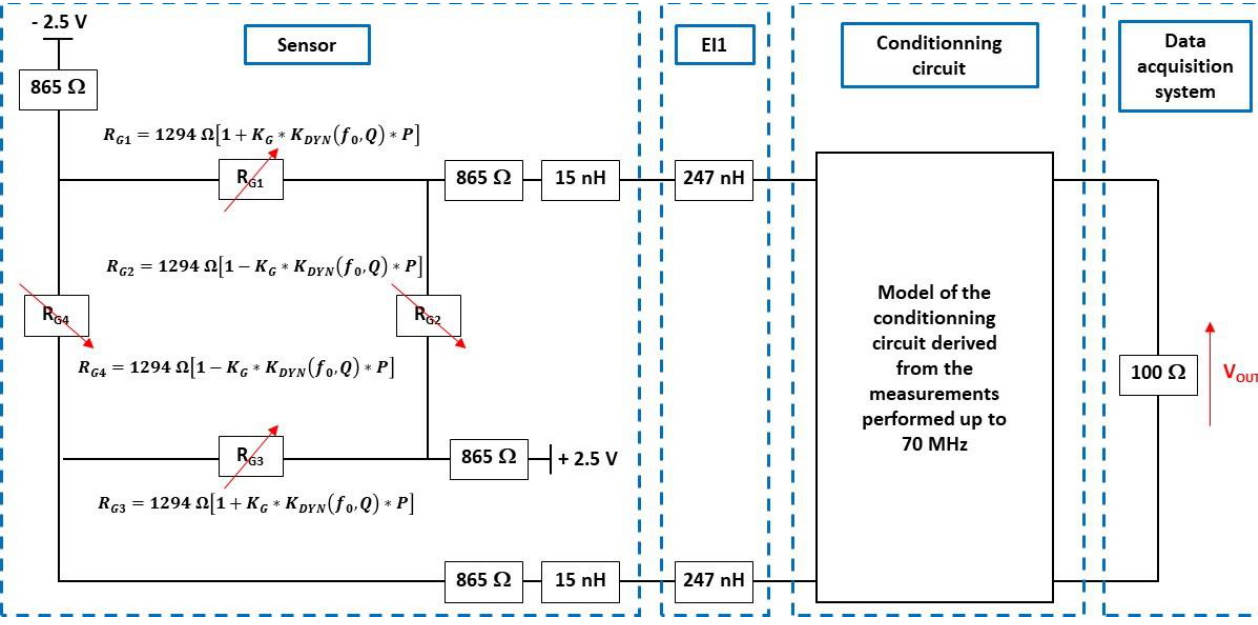
Figure 27. Electrical model of entire measurement setup implemented in ADS software.